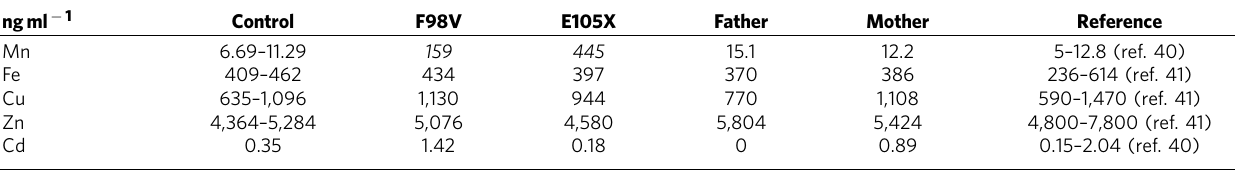
Table 2 | Whole-blood Mn levels are raised in SLC39A14 deficiency.